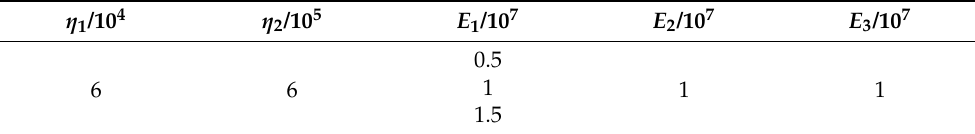
Table 4. E 1 as variable.